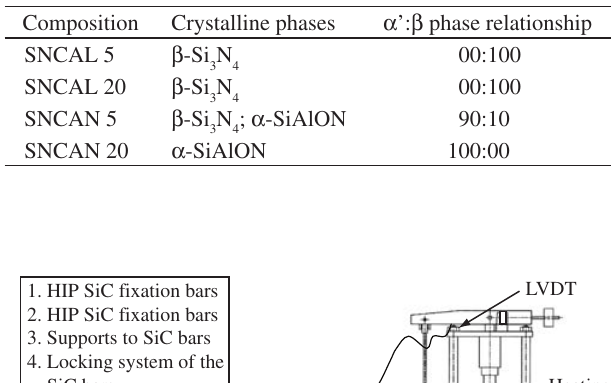
Table 2. Characteristic of the hot-pressed